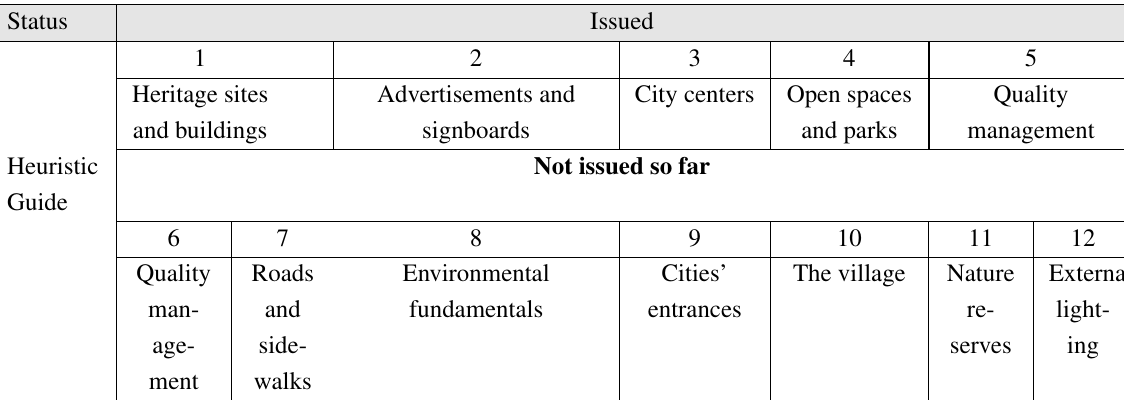
Table 1. The twelve heuristic guides that should be issued by